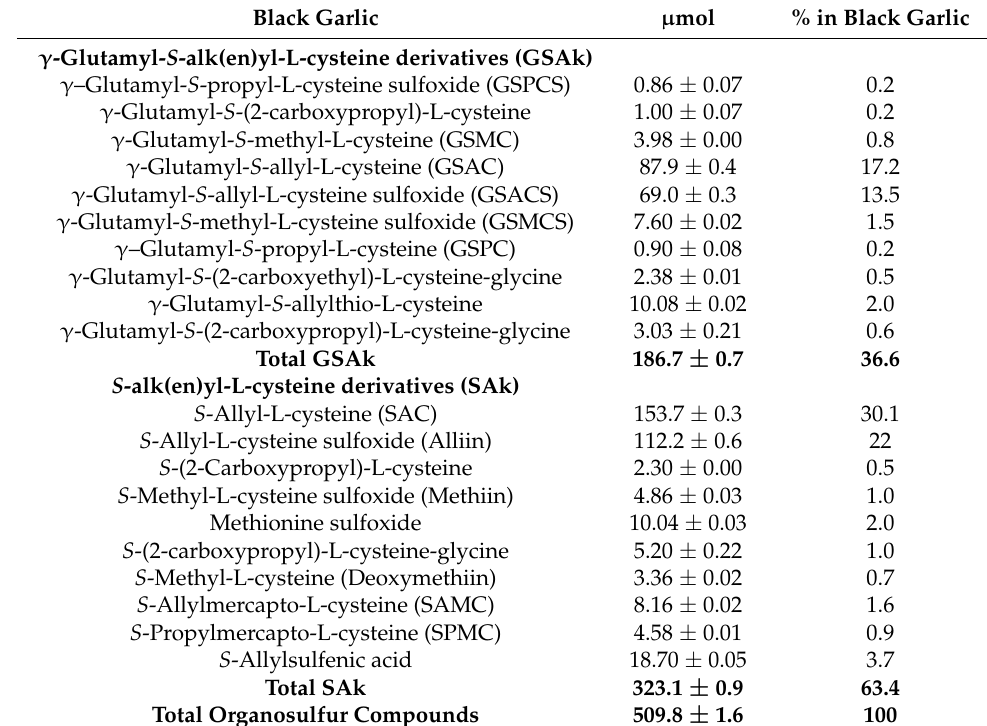
Table 1. Organosulfur compounds identified and quantified in 20 g of black garlic expressed as mean ± SD. Black Garlic µ